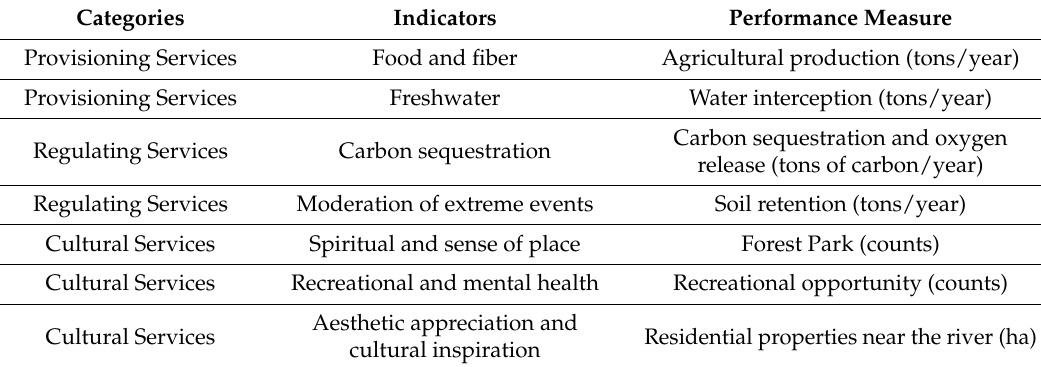
Table 2. Ecosystem service